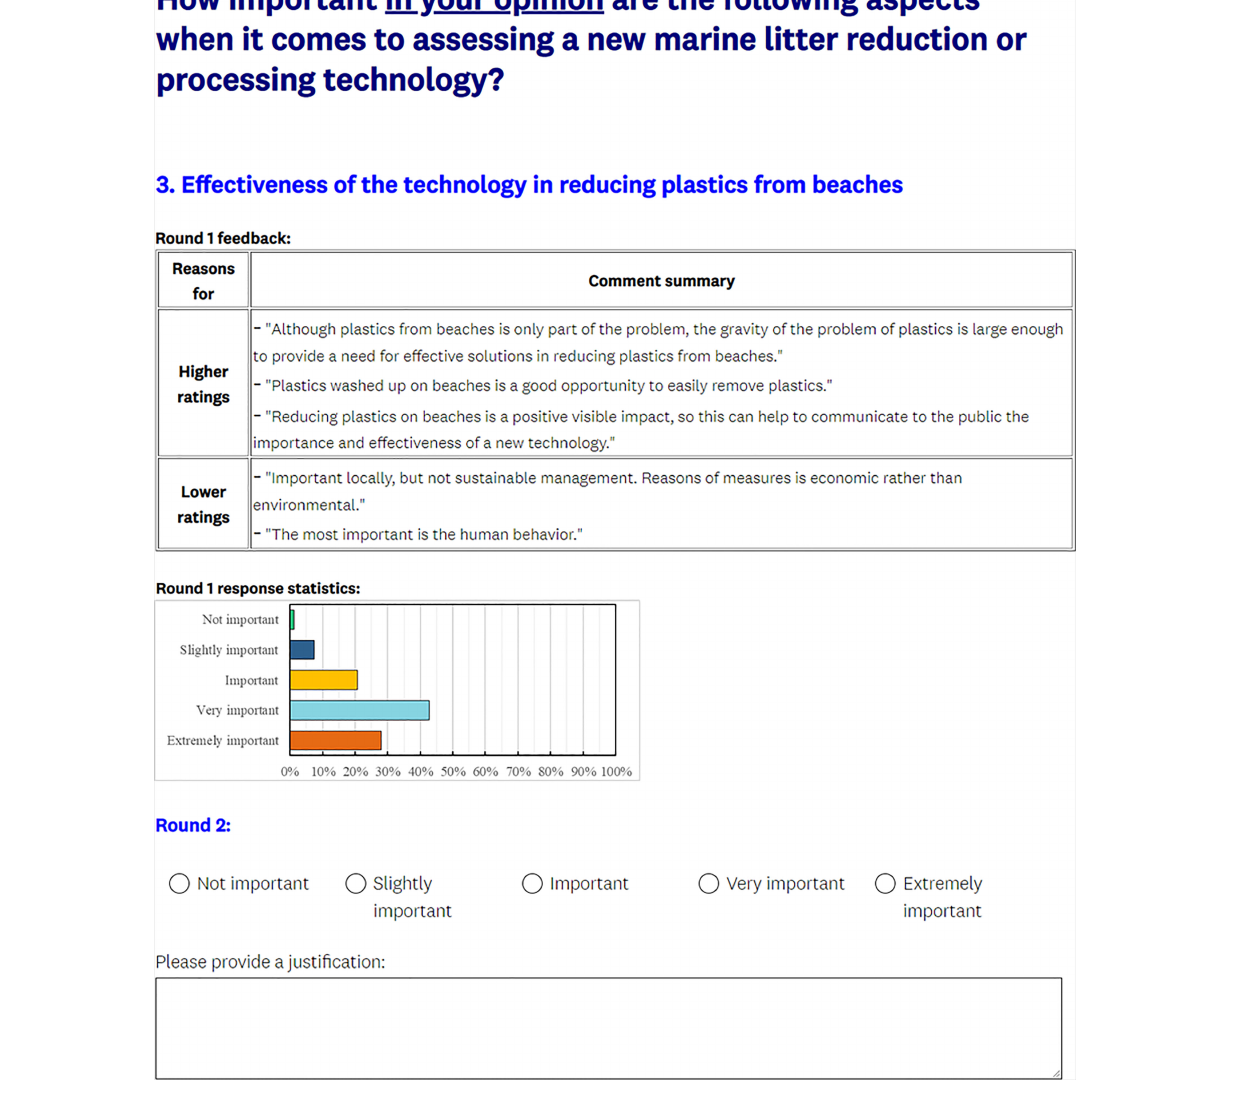
FIGURE 2 | Online questionnaire of the second Delphi round on the SurveyMonkey ®